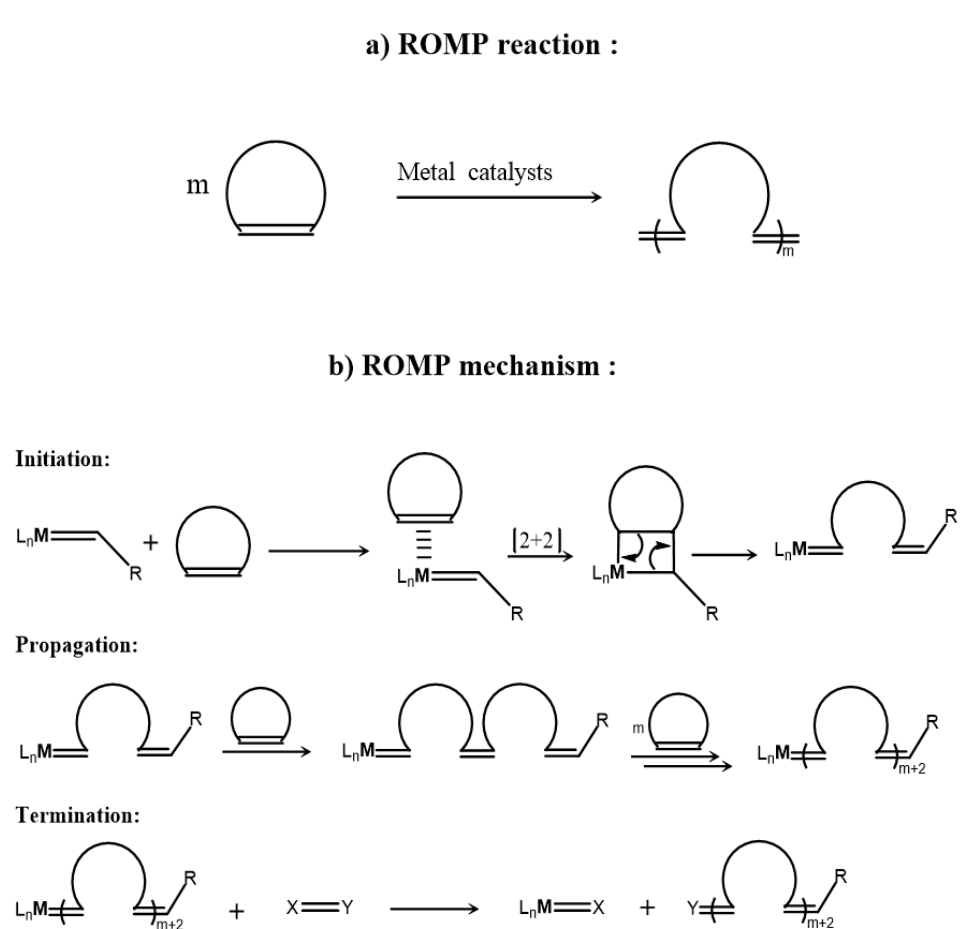
Figure 1. ( a ) ROMP reaction of cyclic olefins (double bonds along the main chain). ( b ) Simplified general mechanism of ROMP reaction of cyclic olefins.